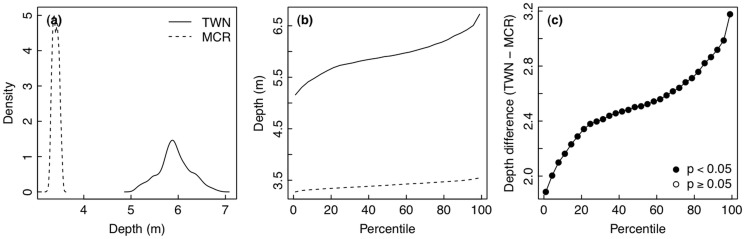
Comparison of seawater depth between Moorea [MCR] and Taiwan [TWN].(a) Histogram of the frequency densities of depth values observed during the deployments. (b) Distributions of frequencies of depth values during the deployments. (c) Differences in depth (TWN—MCR) for each percentile of the distribution of seawater depth, tested whether different from zero using Monte Carlo randomizations.